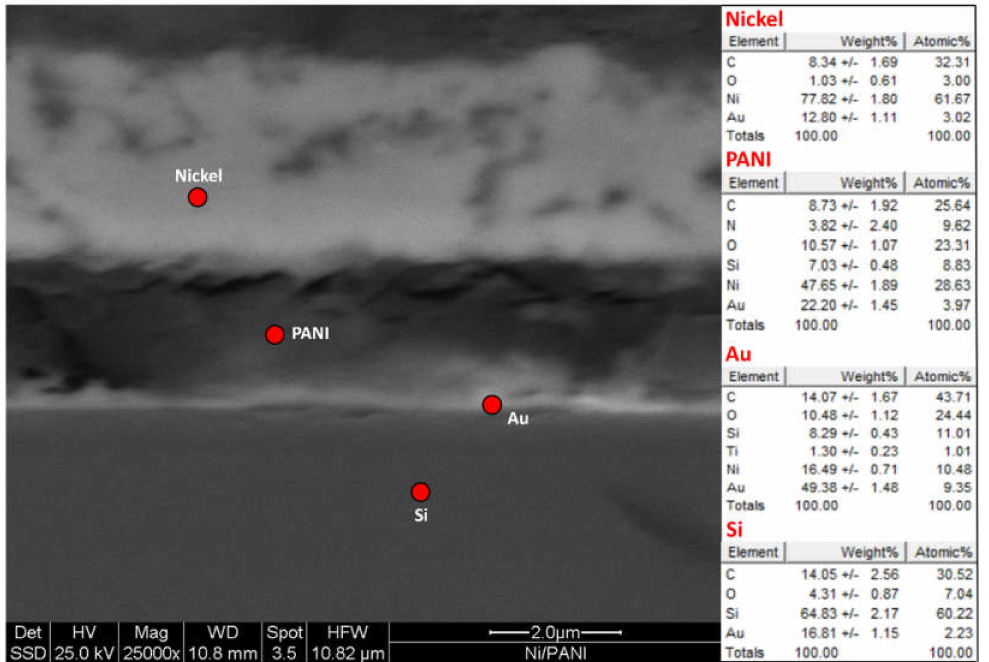
Figure 6. SEM micrographs (cross section) of the layered Au|PANI|Ni